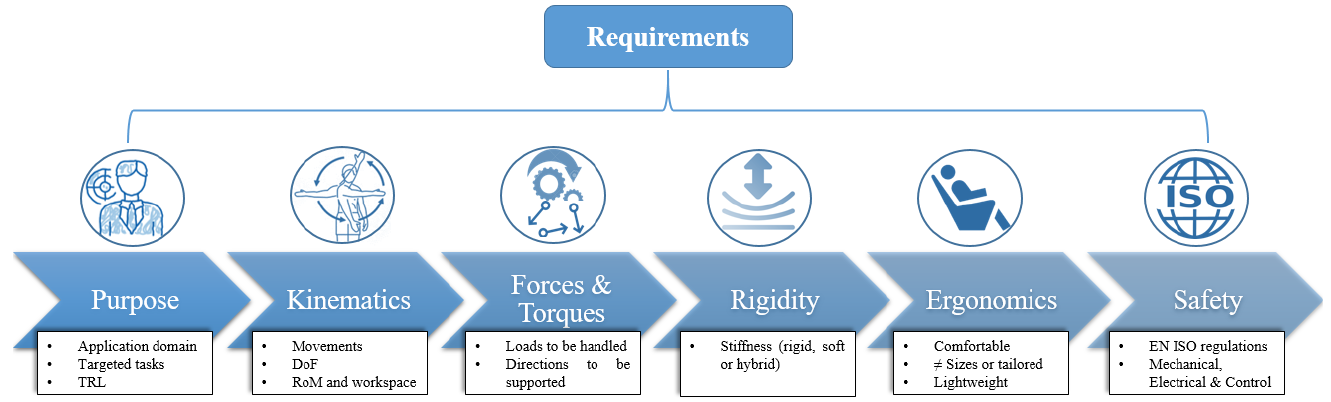
Figure 7. Flow of requirements for exoskeletons in